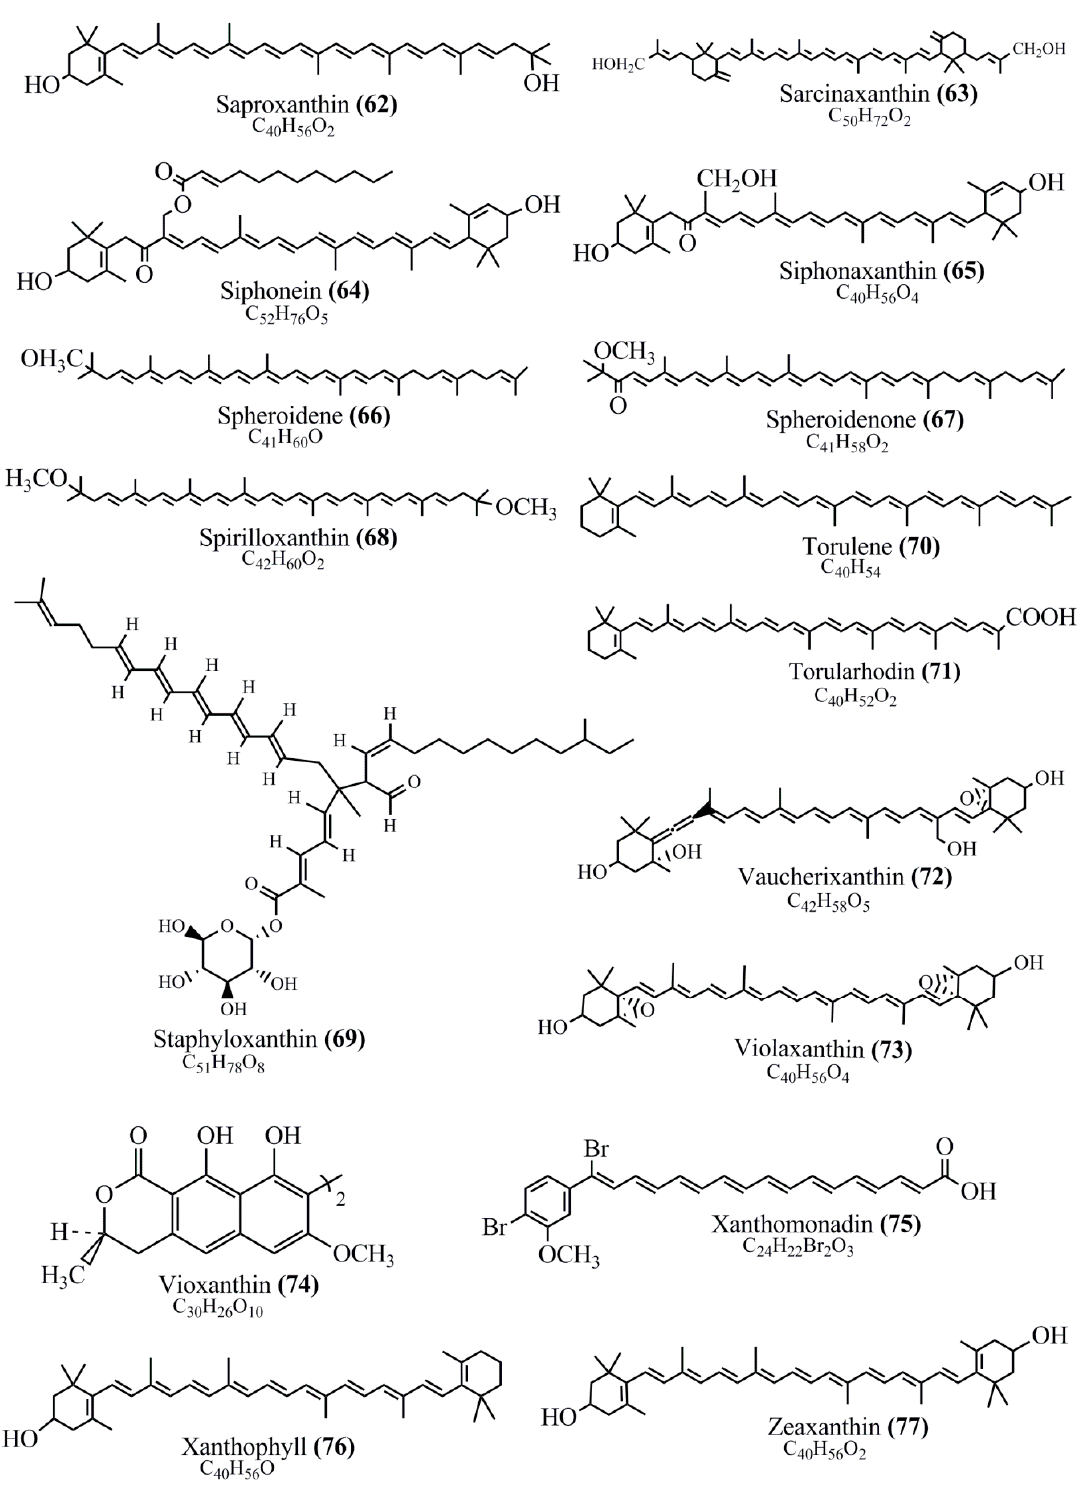
Figure 1. Continued. Figure 1.